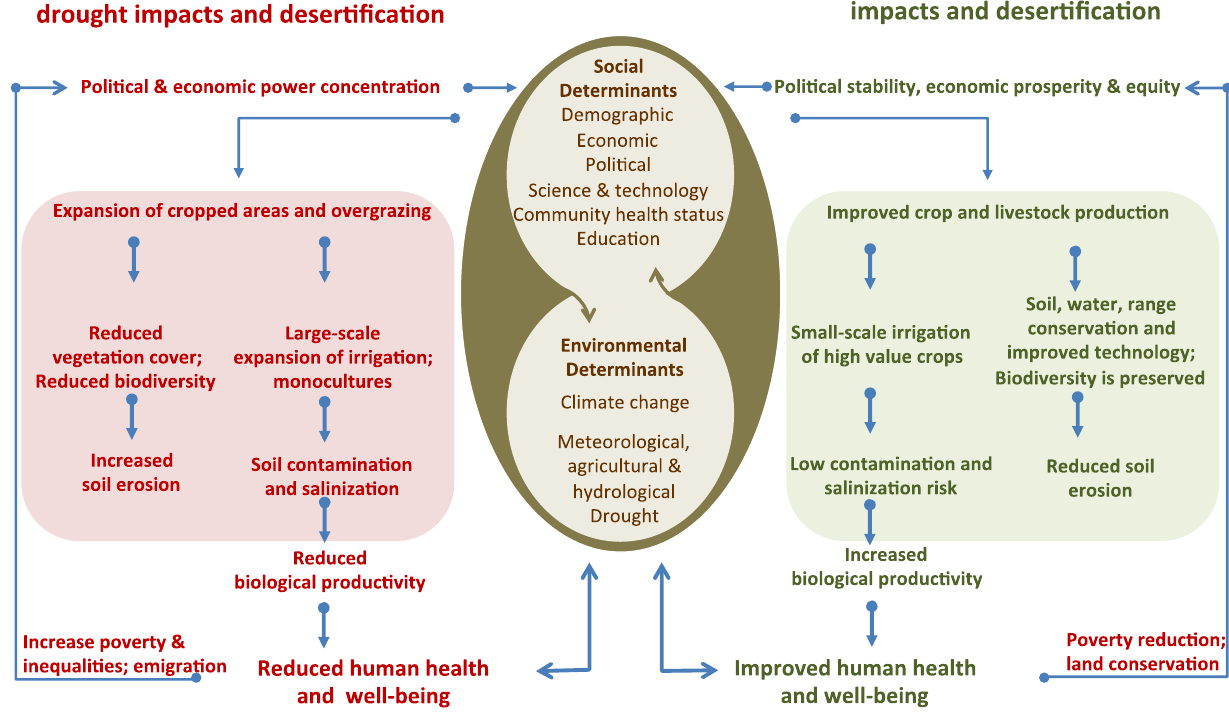
Figure 3. Drivers and pathways of drought and desertification, highlighting the central importance of social and environmental determinants of health and well-being. Adapted from [17,35].